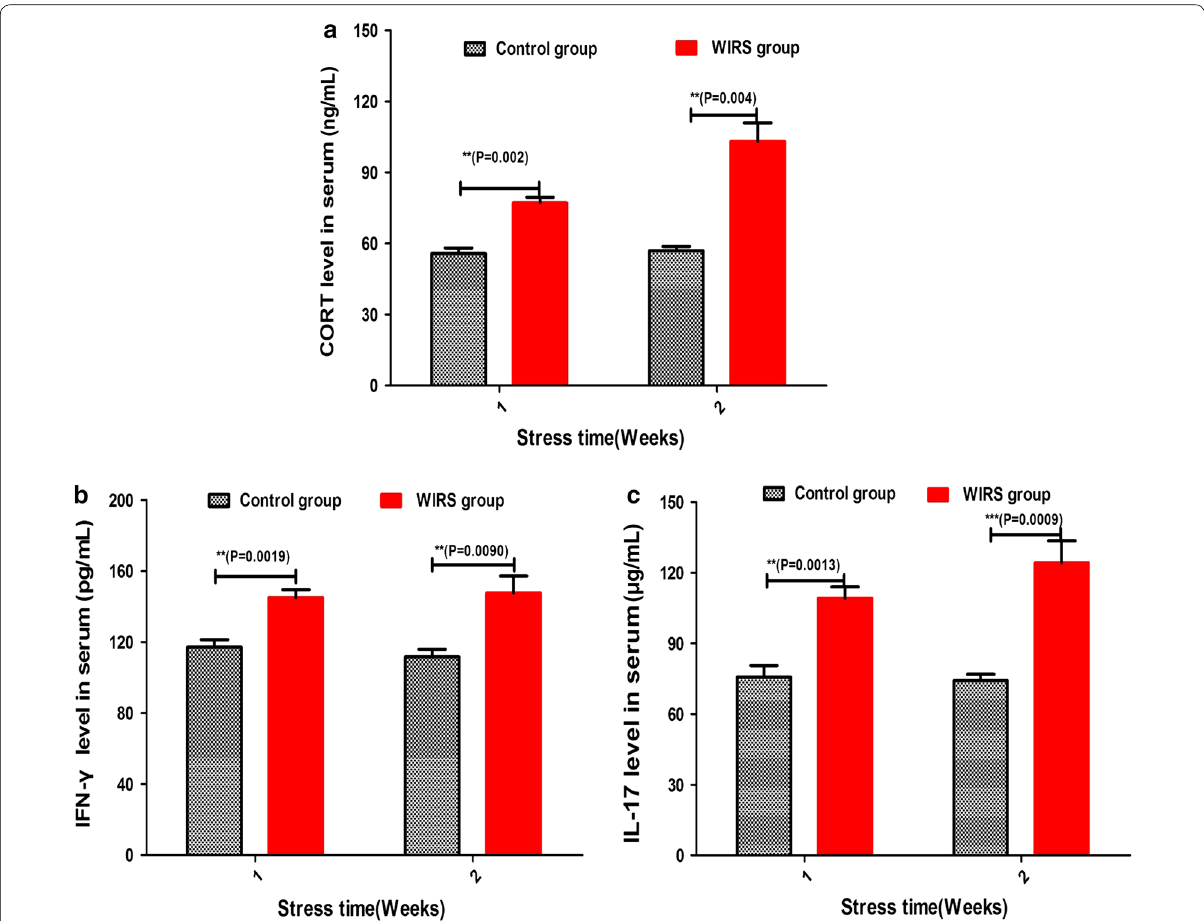
Fig. 1 Behaviour and biochemistry results of the WRIS. a CORT levels in serum; b IFN-γ levels in serum; c IL-17 levels in serum. Data in a , b , and c are expressed as the mean SEM (n 5). *P < 0.05; **P < 0.01; ***P < ± =